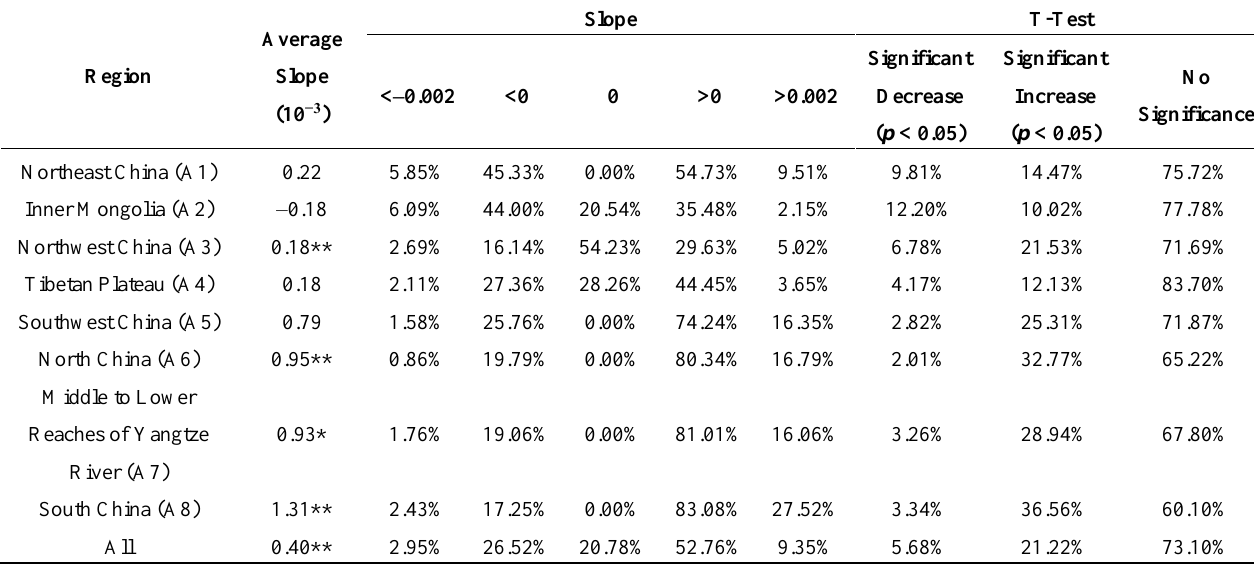
Table 2. Growing-season Normalized Difference Vegetation Index (NDVI) trends from 1982 to 2011 in sub-regions and whole